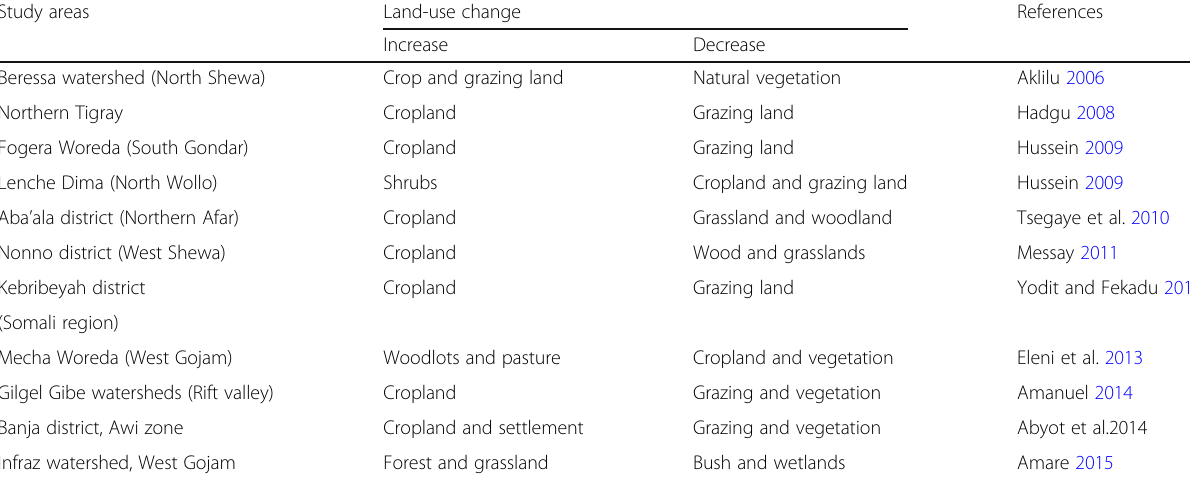
Table 8 Temporal and spatial land-use dynamics in some catchments of Ethiopia